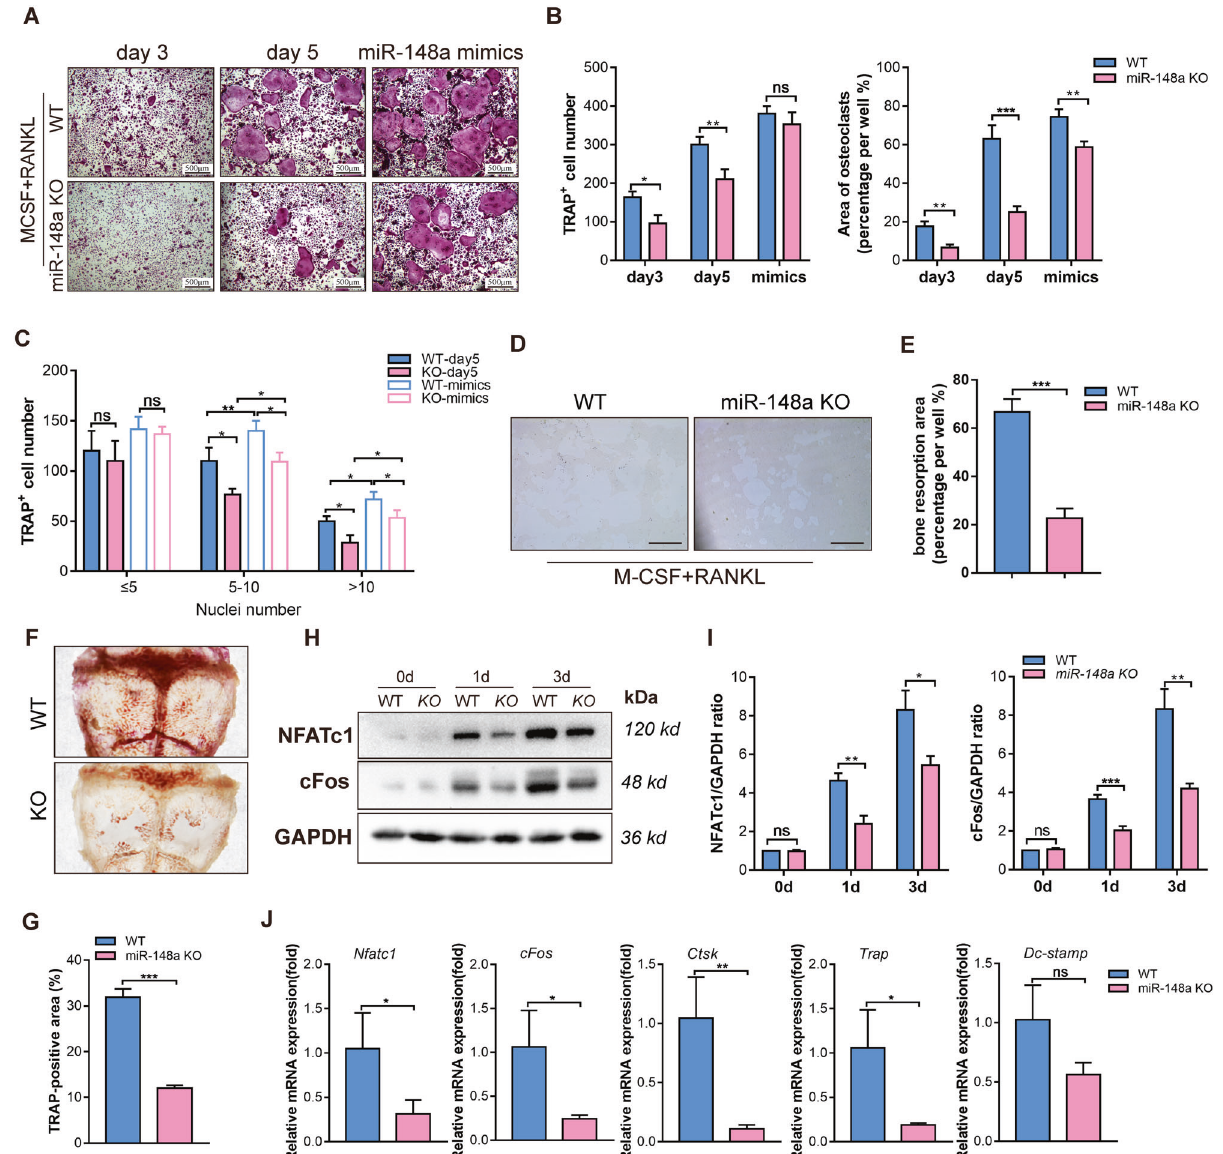
Fig. 3 Deletion of miR-148a inhibits osteoclast formation and function in vitro. A TRAP staining to detect osteoclastogenesis of WT and miR-148a-deletion BMMs under RANKL stimulation; For mimics-supplementation group, the WT- and KO-derived BMMs were transfected with miR-148a mimics at day 1 and day 3, and harvested for TRAP staining at day 5; Scale bar, 500 μ m. B , C Quantitative analysis of osteoclast area and TRAP-positive multinucleated cell numbers in A , n = 3. D WT-and KO-derived BMMs were seeded onto the hydroxyapatite-coated Osteo Assay plates and stimulated with RANKL (50 ng/mL) for 5 days; Scale bar, 200 μ m. E Quantitative analysis of bone resorption area in D , n = 3. F Representative TRAP staining of the whole calvaria from WT and KO mice. G Quantitative analysis of TRAP-positive area in F ; n = 3. H The protein expression of NFATc1 and c-Fos were determined by Western blot at 0, 1, and 3 days after RANKL stimulation. I Quantitative analysis of protein expression in G ; n = 3. J Quantitative analysis of osteoclast-related gene expression ( Nfatc1 , c-Fos , Ctsk , Trap , and Dc-stamp ) in WT and miR-148a KO osteoclasts by RT-qPCR; n = 3. (All data are presented as mean ± SD; * p < 0.05; ** p < 0.01; *** p < 0.001; ns no signi fi cance, compared to the corresponding control